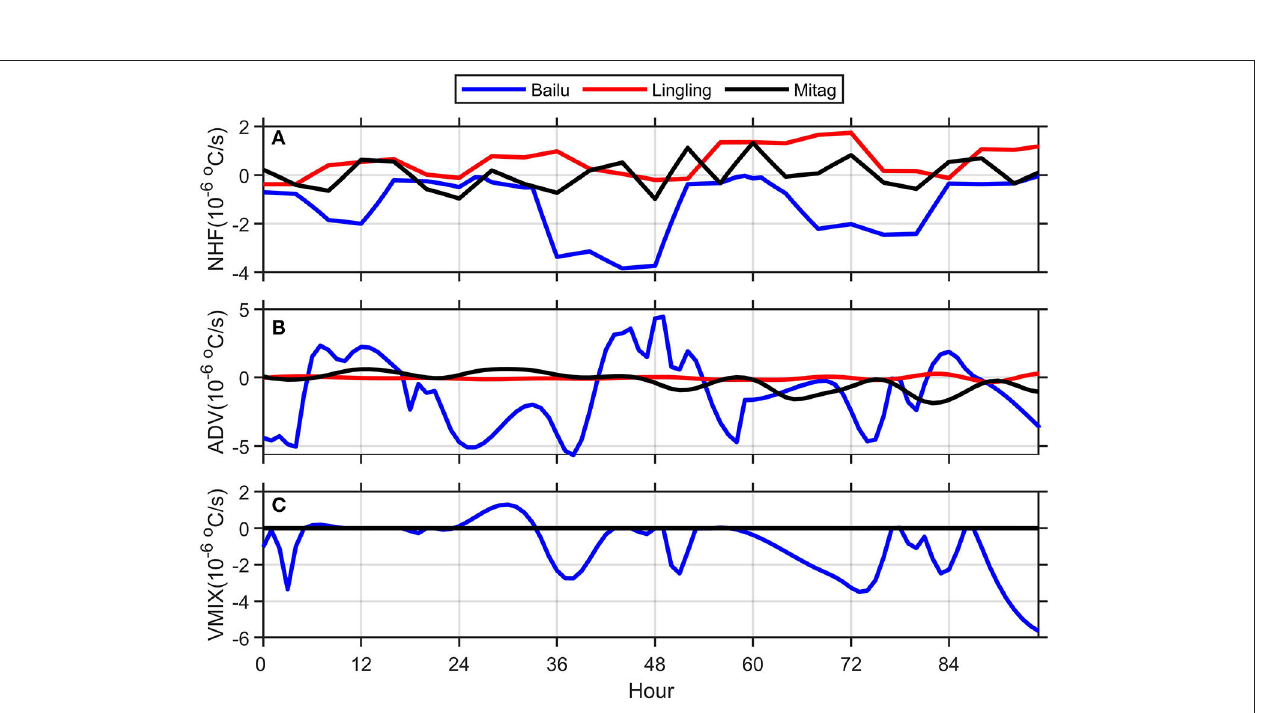
Frontiers in Marine Science |